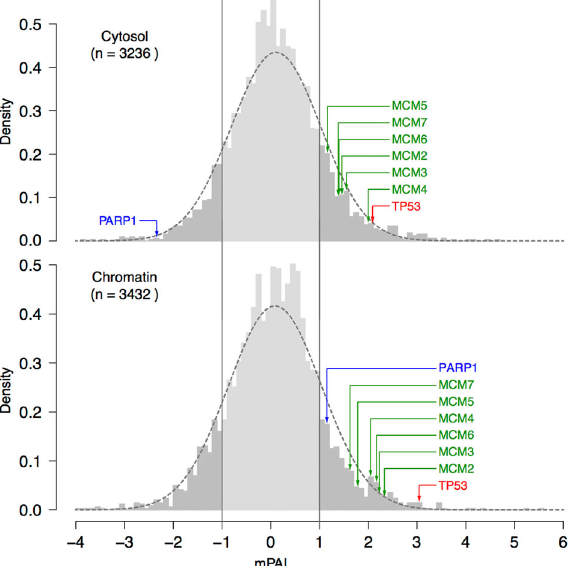
Fig. 3 Distribution of mutant p53 association index (mPAI) scores in the cytosol ( top ) and chromatin ( bottom ) fractionations. Histograms of mPAI values (for equation see statistics in the methods) show close fi t to normal curves (in dashed lines ) obtained with the same mean ( µ = 0.0060 for cytosol, µ = 0.085 for chromatin) and standard deviation ( σ = 0.92 for cytosol, σ = 0.96 for chromatin). As expected (and as a negative control of the experiments and the mPAI statistic), most proteins are not signi fi cantly impacted by mtp53 depletion, showing − 1 < mPAI < 1 (shaded in light gray ). As a positive control, the mTP53 protein level (in red ) shows signi fi cantly high positive mPAI values. As another positive control, the PARP1 levels (in blue ) show contrasting mPAI values between the two fractionations, consistent with previous experimental results. 6 The six components of the MCM2 – 7 complex (in green ) show signi fi cant